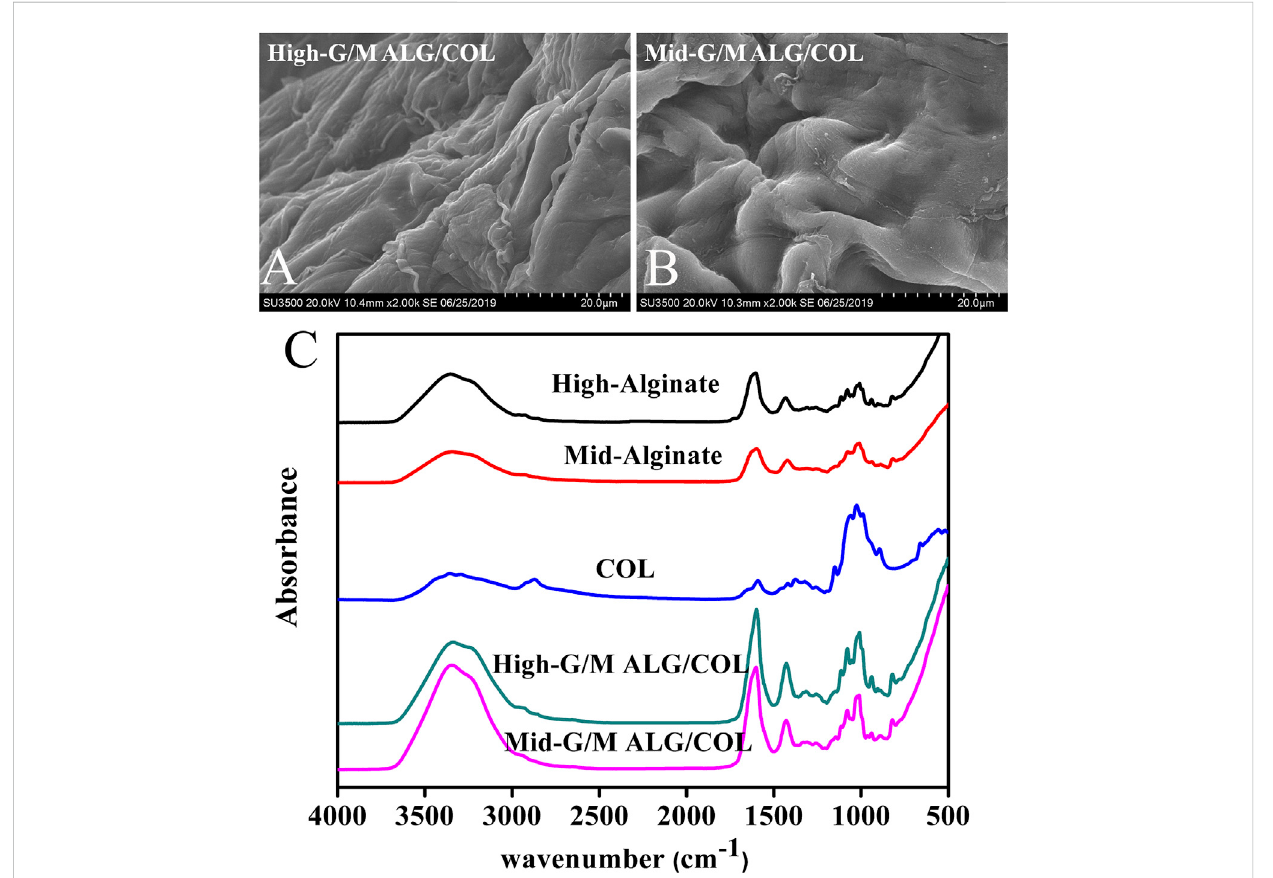
FIGURE 2 SEM images of the morphology of (A) High-G/M and (B) Mid-G/M ALG/COL hydrogels. (C) FTIR spectra of High-G/M and Mid-G/M ALG/COL